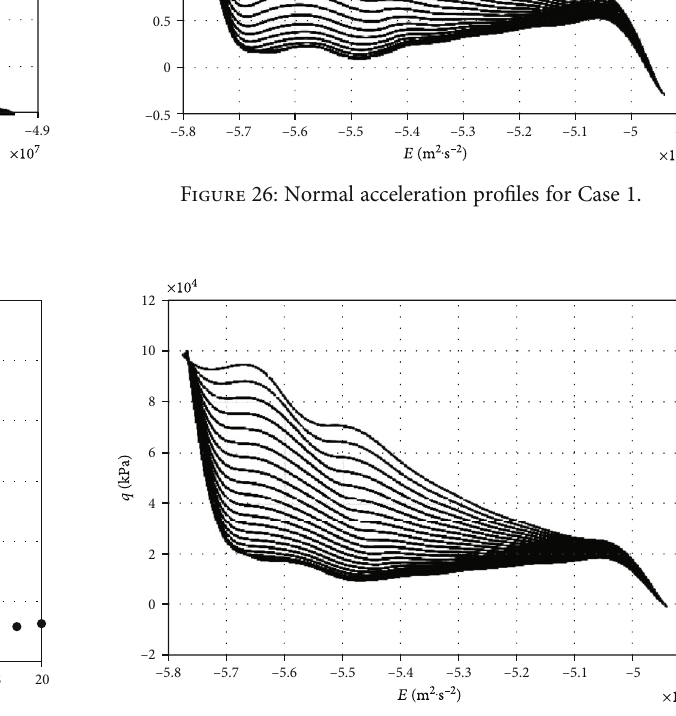
Figure 27: Dynamic pressure pro fi les for Case 1.